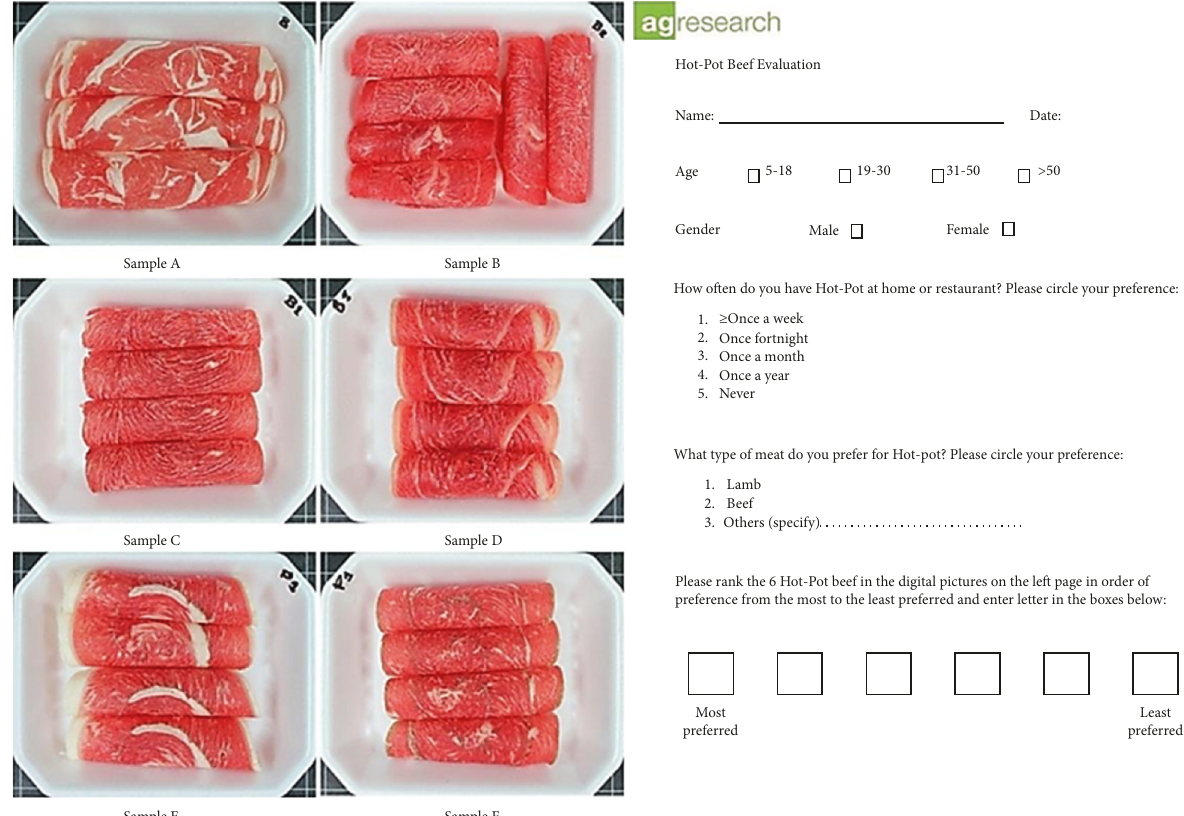
Figure 2: The English version of the questionnaire used in the survey of the three consumer